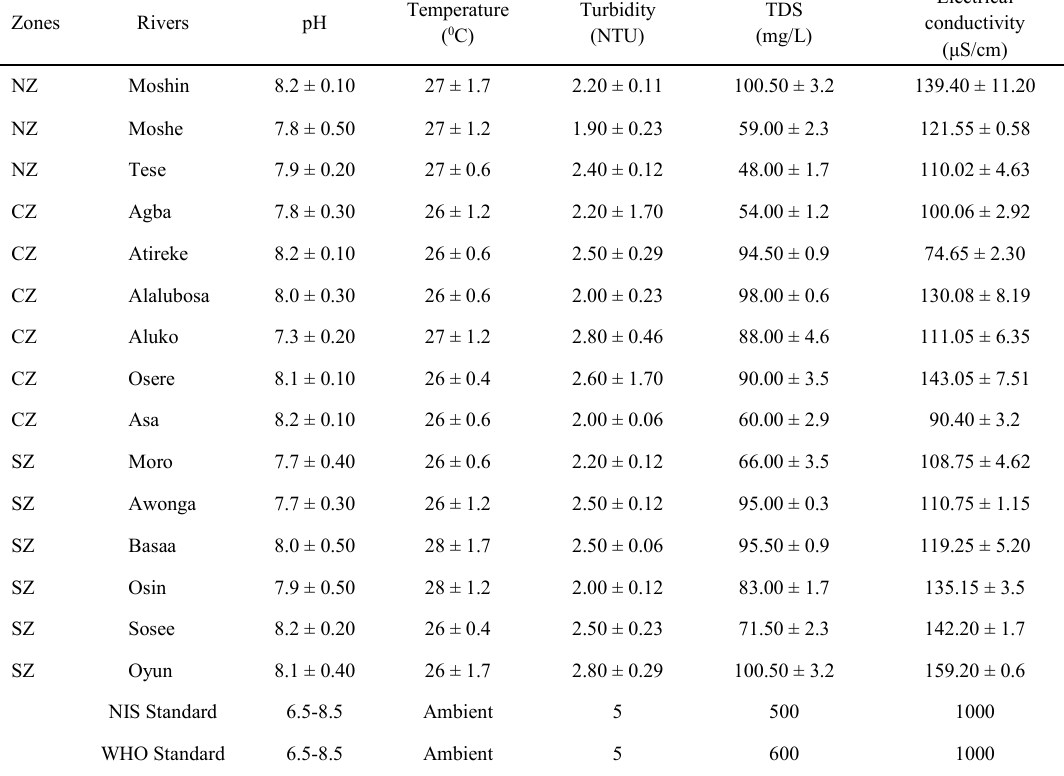
Table 2: Mean distribution of some physical parameters in the study area during the rainy